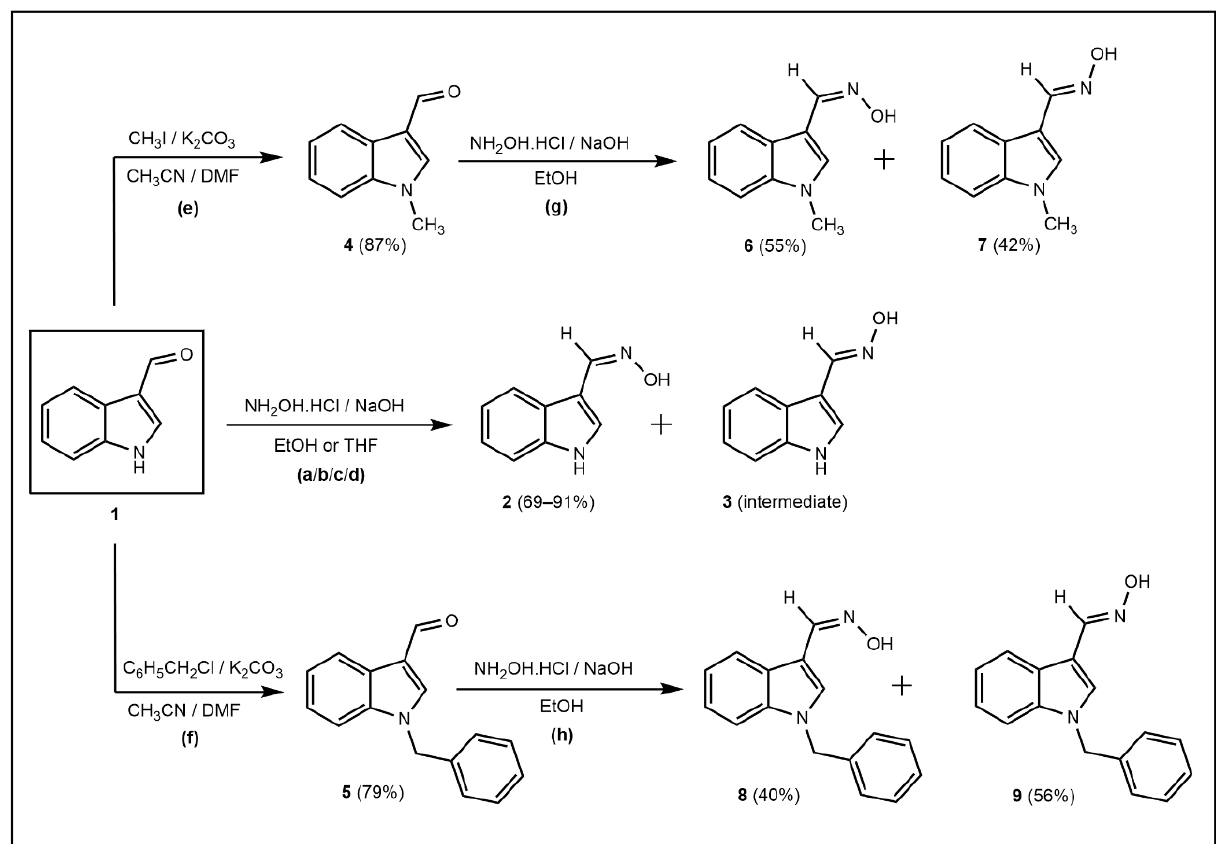
Scheme 1. Synthesis of indole-3-carbaldehyde oxime derivatives and their intermediates (Compound 2 – 9 ). Reagents and conditions: ( a ) NH 2 OH.HCl (5 eq), aq. NaOH (2 eq), 95% EtOH, 0–27 ◦ C, 2 h; ( b ) NH 2 OH.HCl (5 eq), aq. NaOH (5 eq), 95 EtOH, 0 – 27 °C, 2 h; ( c ) NH 2 OH.HCl (5 eq), aq. NaOH (2 eq), THF, 0 – 27 °C, 4 h and 15 min; ( d ) NH 2 OH.HCl (5 eq), aq.